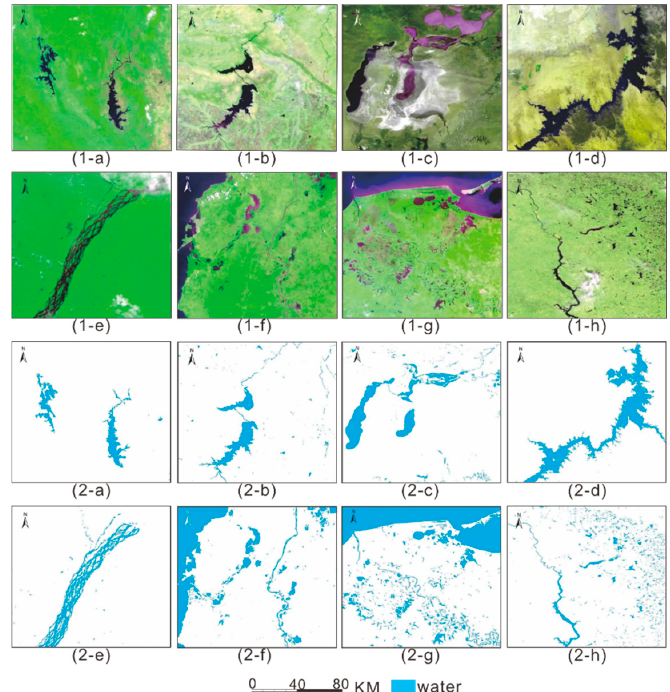
Figure 14. Global stability test sample: ( a ) Mountain lakes in Thailand; ( b ) Lake Gandhi in India; ( c ) Aral Sea in Kazakhstan; ( d ) Nasser reservoir in Egypt; ( e ) Congo river; ( f ) Magdalena river in Colombia; ( g ) Mexican coastal lake; ( h ) Mississippi River in the United States. The OA and Kappa coefficients of the eight test areas are shown in Table 4. Table 4. The coefficient values of overall classification accuracy (OA) and Kappa in the eight test areas.